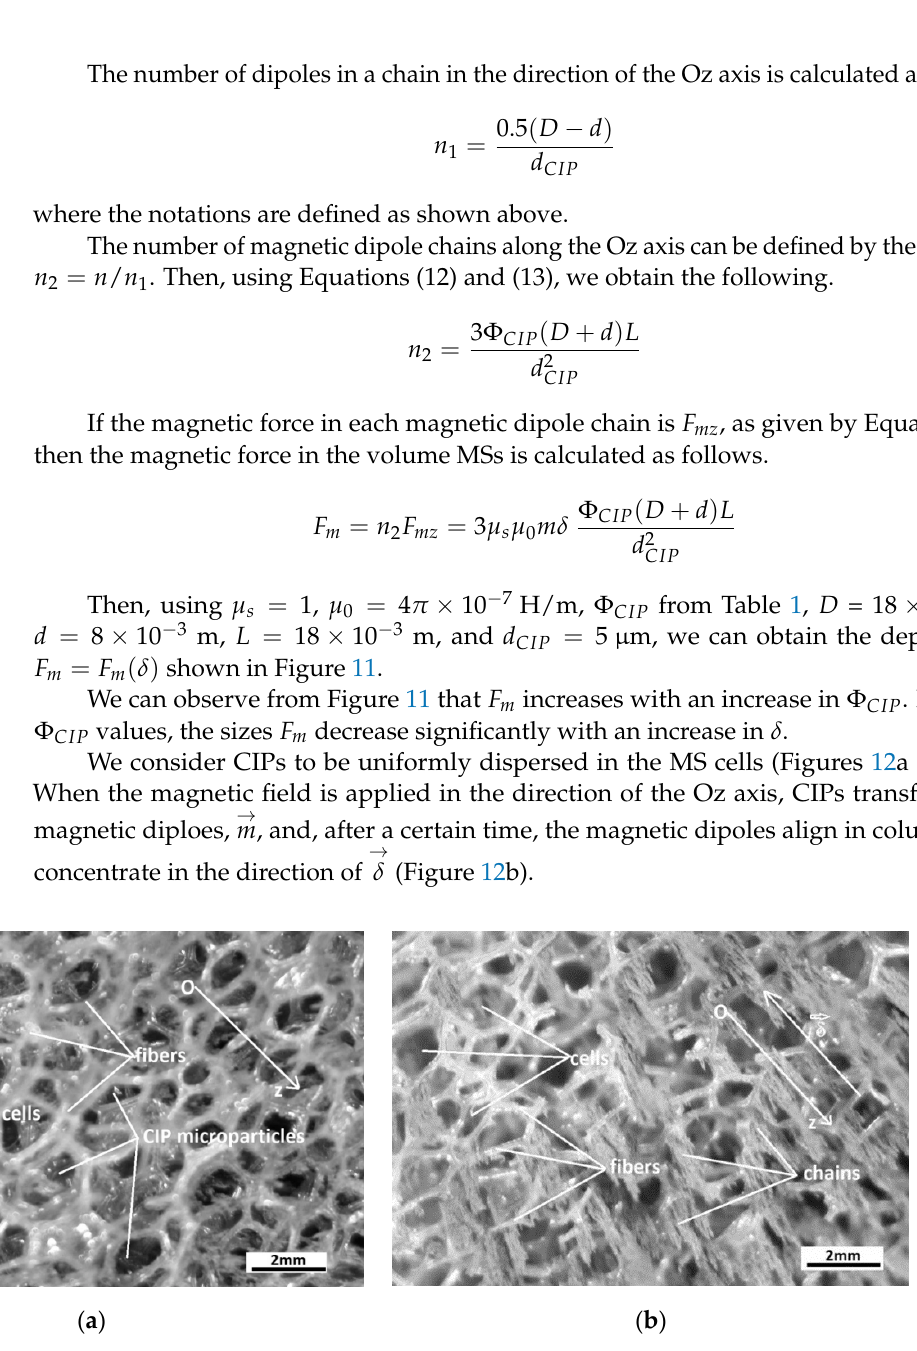
Figure 12. ( a ) MS sponges in the absence of a magnetic field; ( b ) MS when subjected to a magnetic field. The Oz axis has its origin on the central axis of the CCs, and (cid:2012)(cid:1318) is the vector of magnetic field intensity gradient.